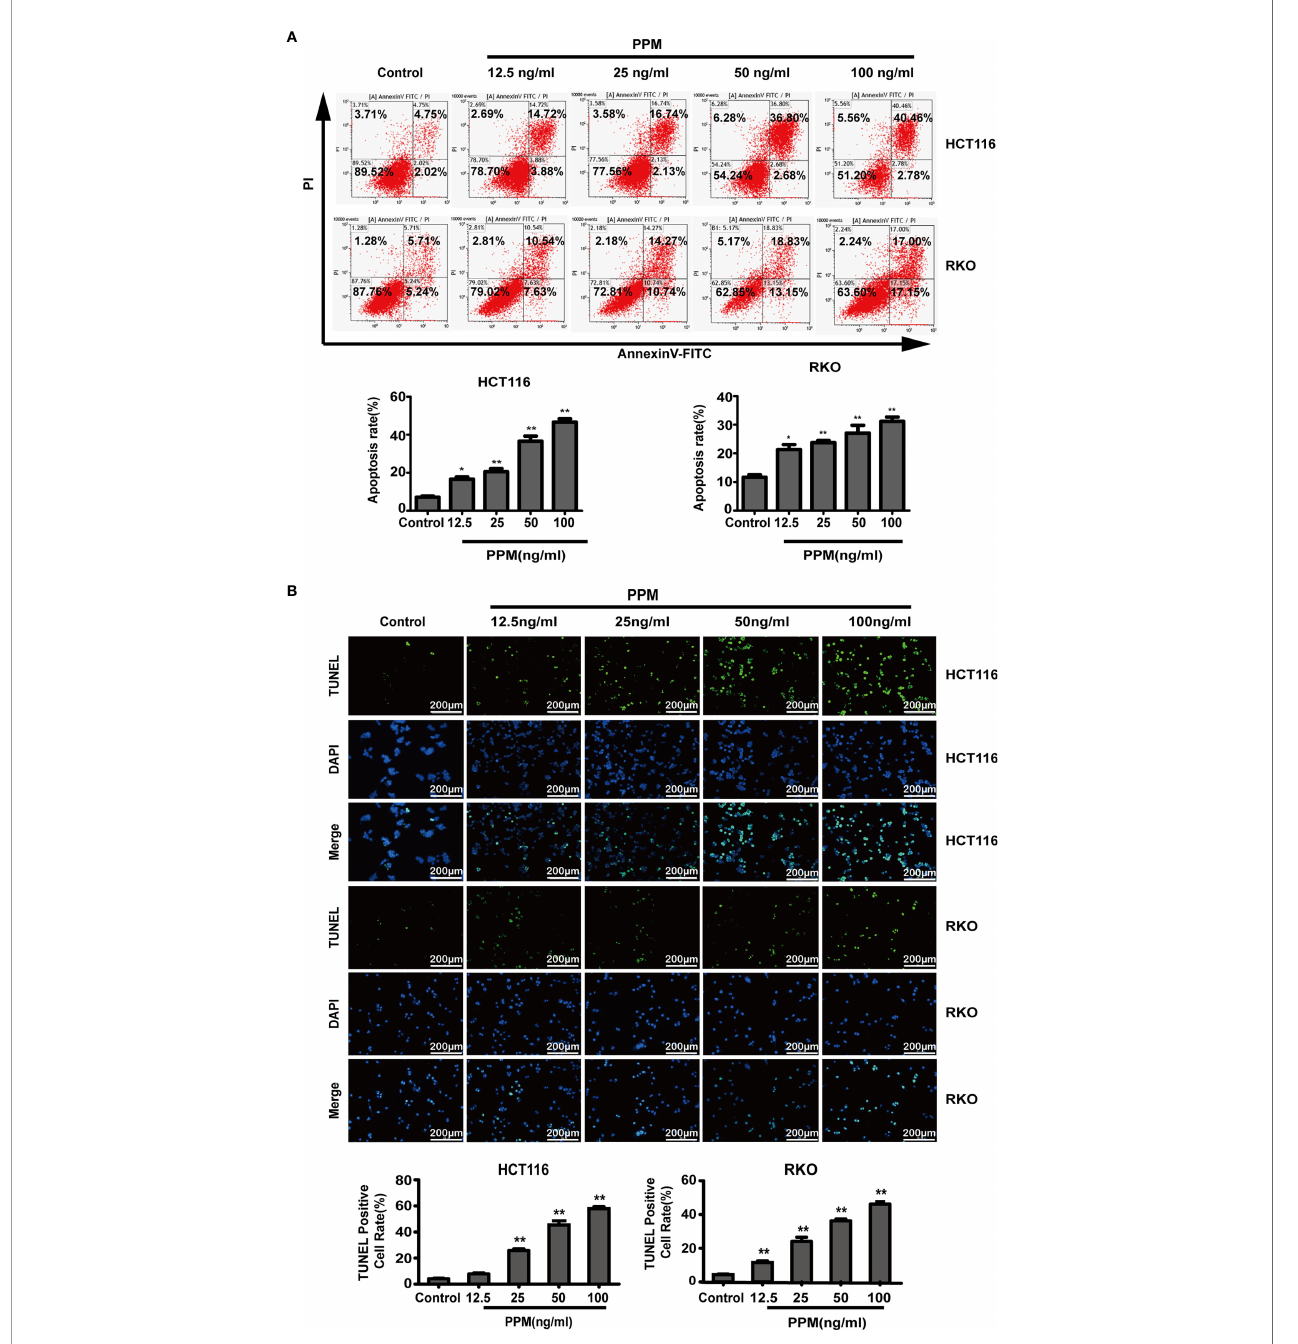
FIGURE 2 | Periplocymarin (PPM) induces apoptosis in colorectal cancer cells. (A) Flow cytometric analysis of HCT 116 and RKO cells treated with different concentrations of PPM (0, 12.5, 25, 50, or 100 ng/ml) for 24 h. The cells were examined by Annexin V-FITC staining. (B) TUNEL staining of HCT 116 and RKO cells treated with PPM (0, 12.5, 25, 50, or 100 ng/ml) for 24 h. Apoptotic cells (TUNEL-positive cells) exhibit green fl uorescence. Scale bar, 200 m m. Data are shown as means ± SEM. * P < 0.05, ** P < 0.01, vs . untreated control